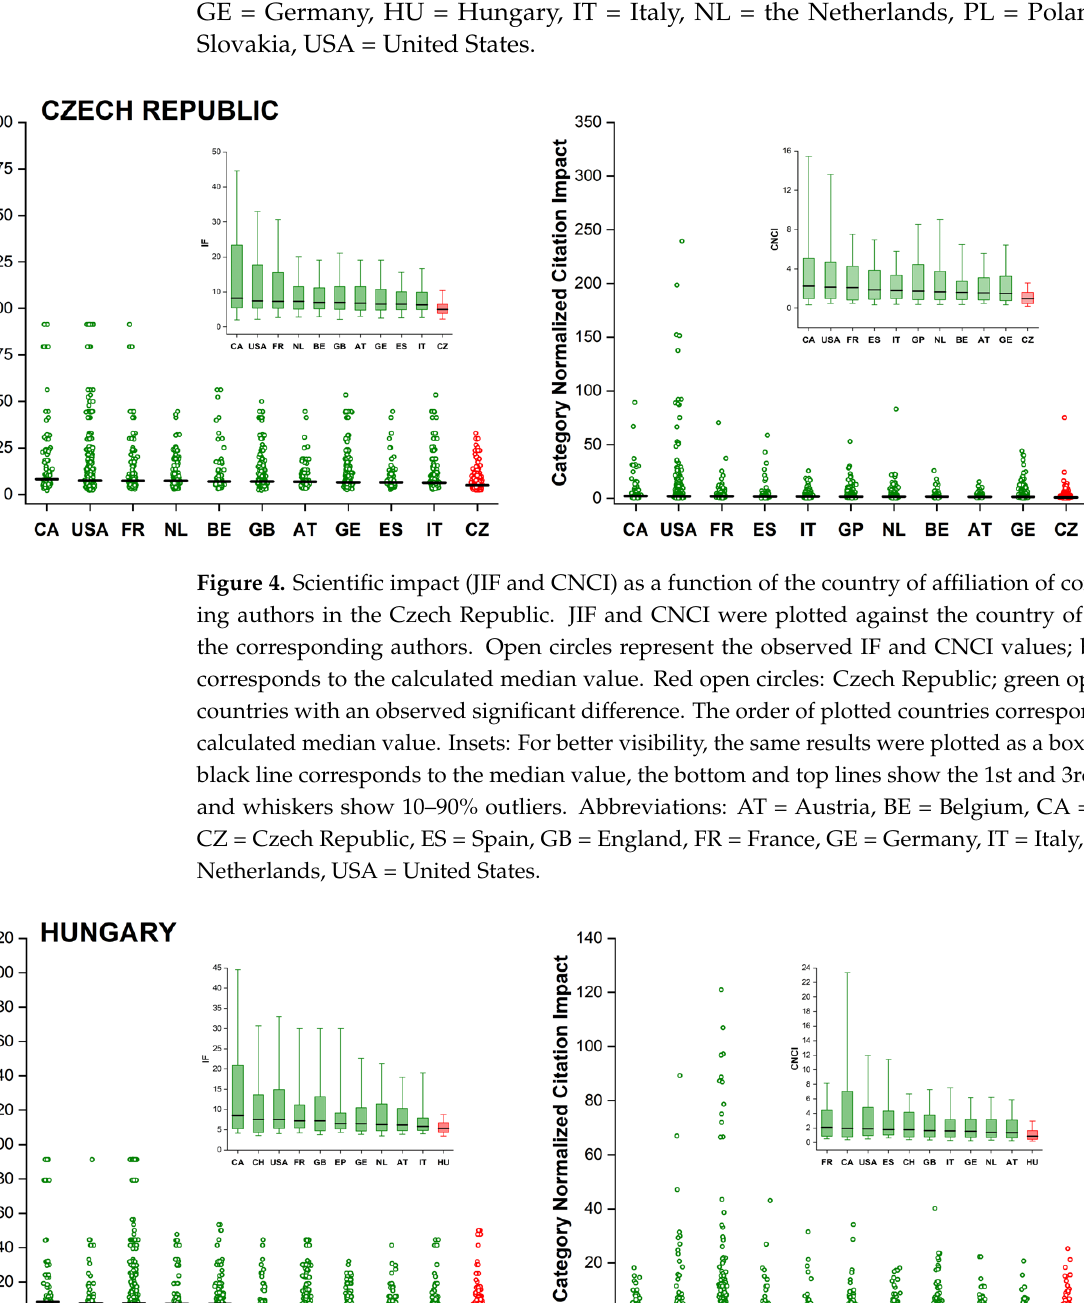
Figure 6. Scientific impact (JIF and CNCI) as a function of the country of affiliation of corresponding authors in Poland. Red open circles: Poland; green open circle: countries with an observed signifi- cant difference; open grey circles: no significant difference between the V4 and compared country. Abbreviations: BE = Belgium, CA = Canada, CH = Switzerland, ES = Spain, GB = England, FR = France, GE = Germany, IT = Italy, NL = the Netherlands, PL = Poland, USA = United States.